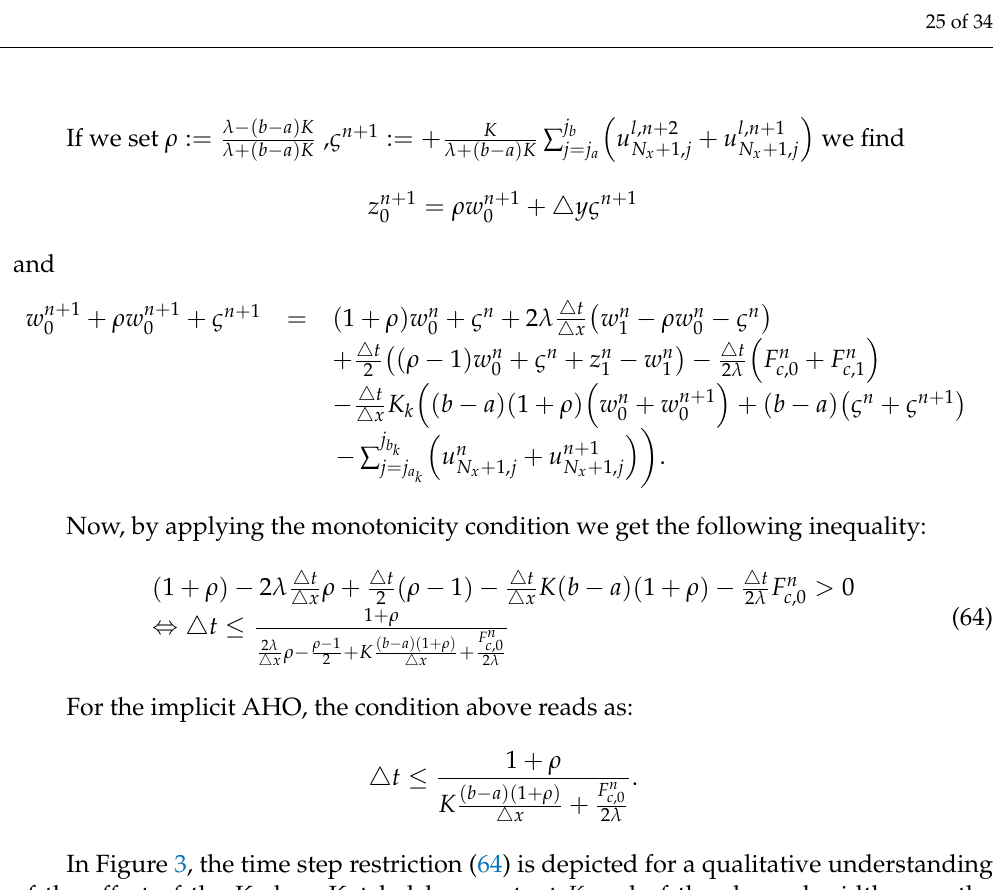
x = 0.01, y = 0.1 and λ = 5 for (cid:52) (cid:52)